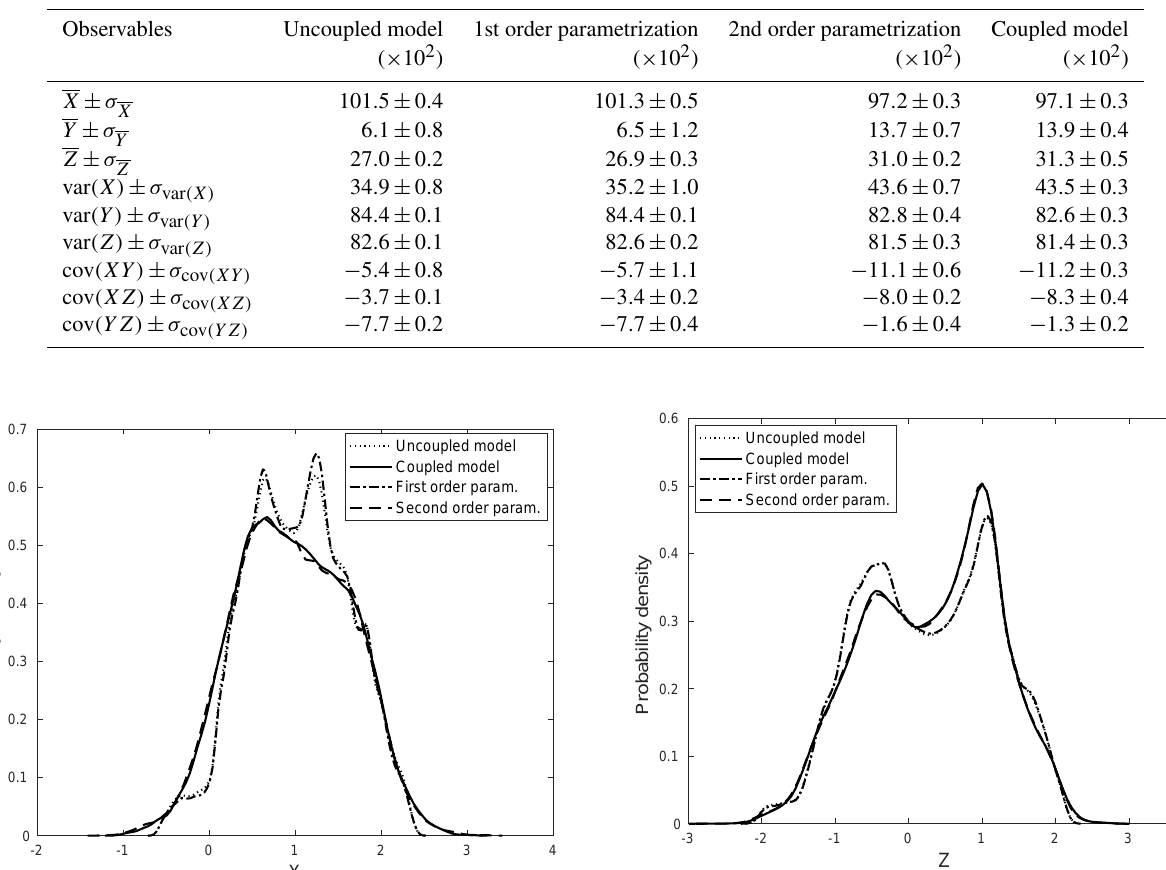
Table 1. Expectation values for the ensemble average of the first two moments of the variables X , Y , and Z . The uncertainty is indicated as standard deviation over the ensemble of realizations with the corresponding standard deviations σ . All the values are multiplied by 10 2 . For case τ = 5, Lorenz 63 acts as a fast-scale model.